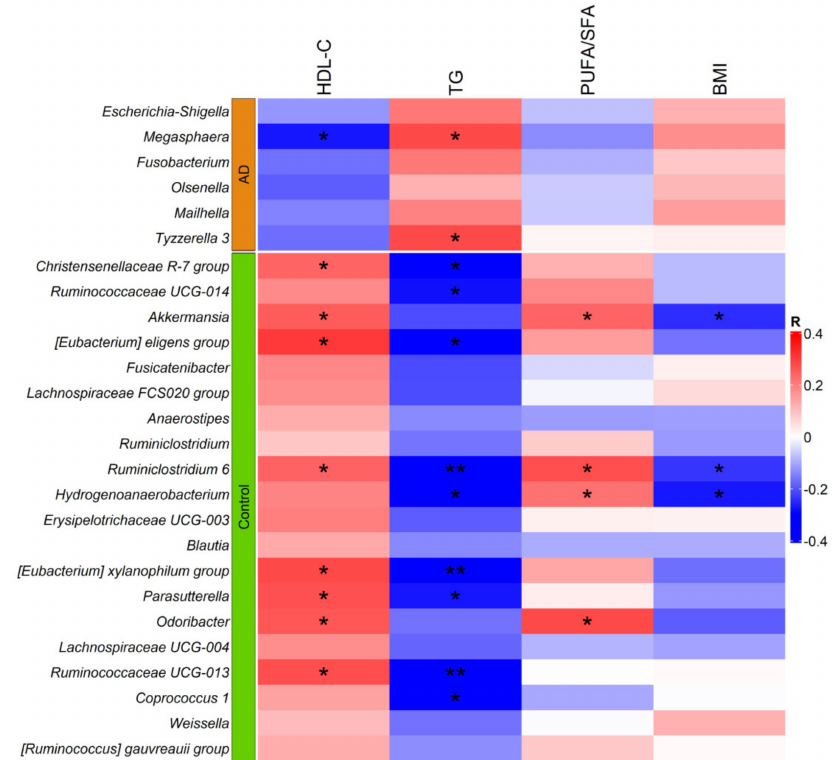
Figure 5. Heatmap showing correlations of relative genera abundance with HDL-C, TG, PUFA/SFA ratio, and BMI. HDL-C, high density lipoprotein cholesterol; TG, triglycerides; PUFA, polyunsatu- rated fatty acids; SAF, saturated fatty acids and BMI, body mass index. * p < 0.05; ** p <